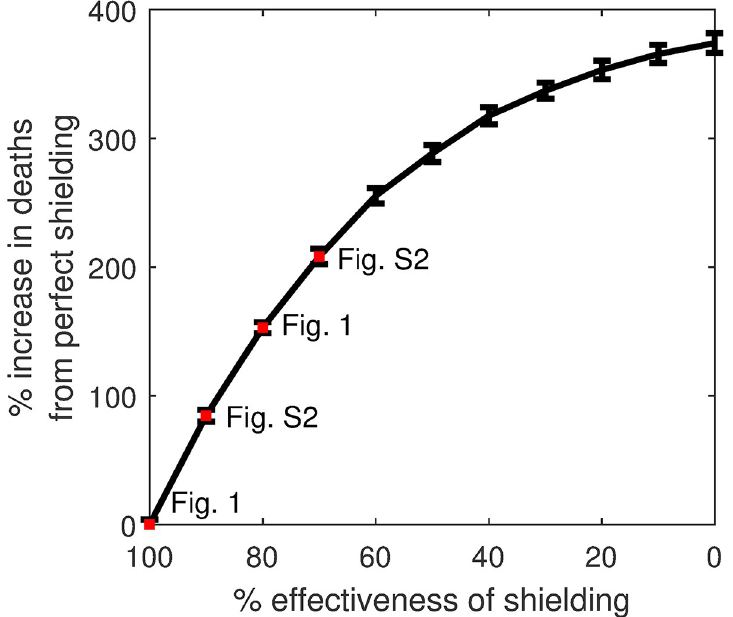
Fig 3. Relative deaths under varying levels of imperfect shielding (compared to perfect shielding). Red dots and labels correspond to figures showing these scenarios, and vertical bars indicate ± 1 standard deviation.